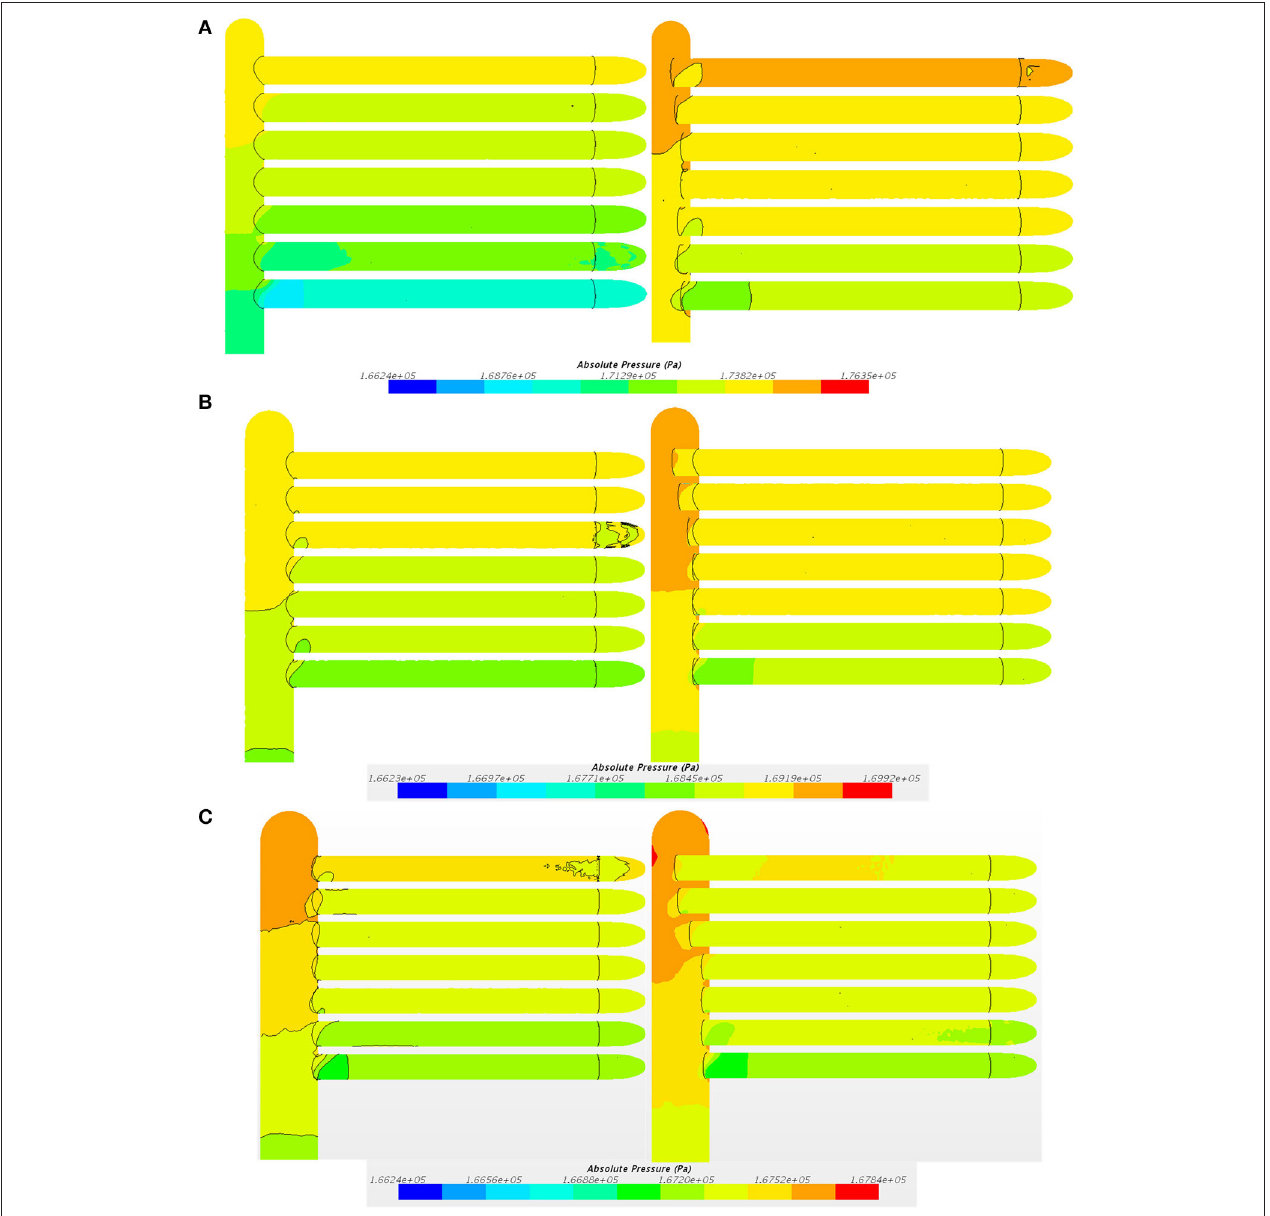
FIGURE 9 | Pressure contour for the header and tubes of heat exchangers (A) Pressure contour for Case 1 (B) Pressure contour for Case 2 (C) Pressure contour for Case 3.